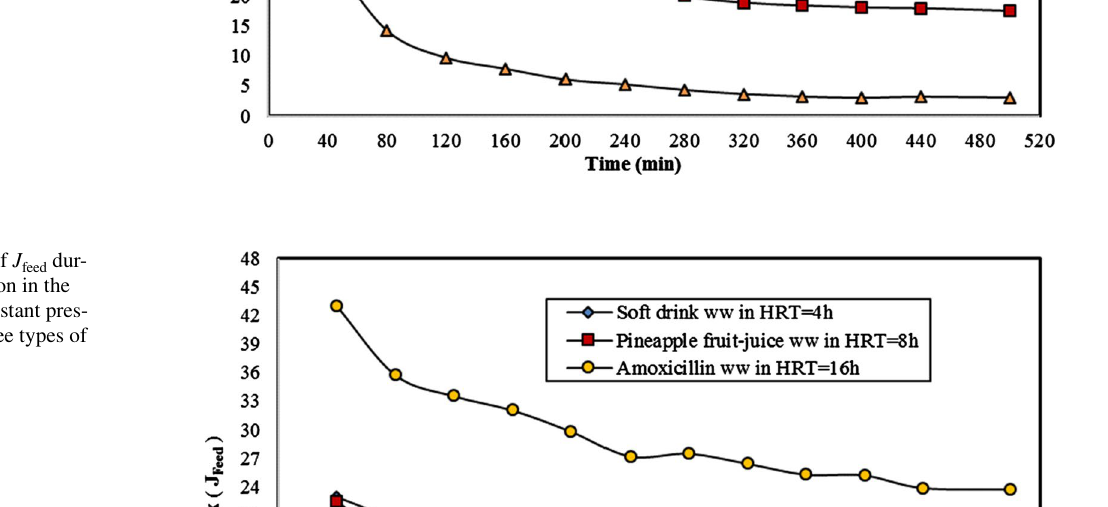
Fig. 9 The results of J long-term filtration in the MF membrane at constant pressure of 15 psi for three types of wastewater